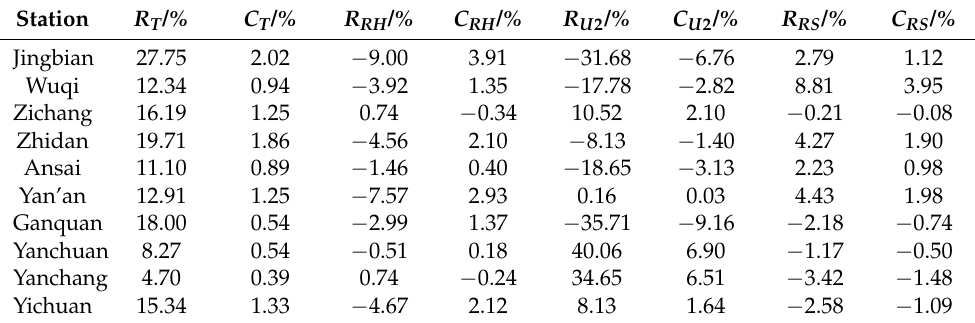
Table 5. Contribution rate of meteorological factors to ET 0 of stations in Yanhe River Basin.